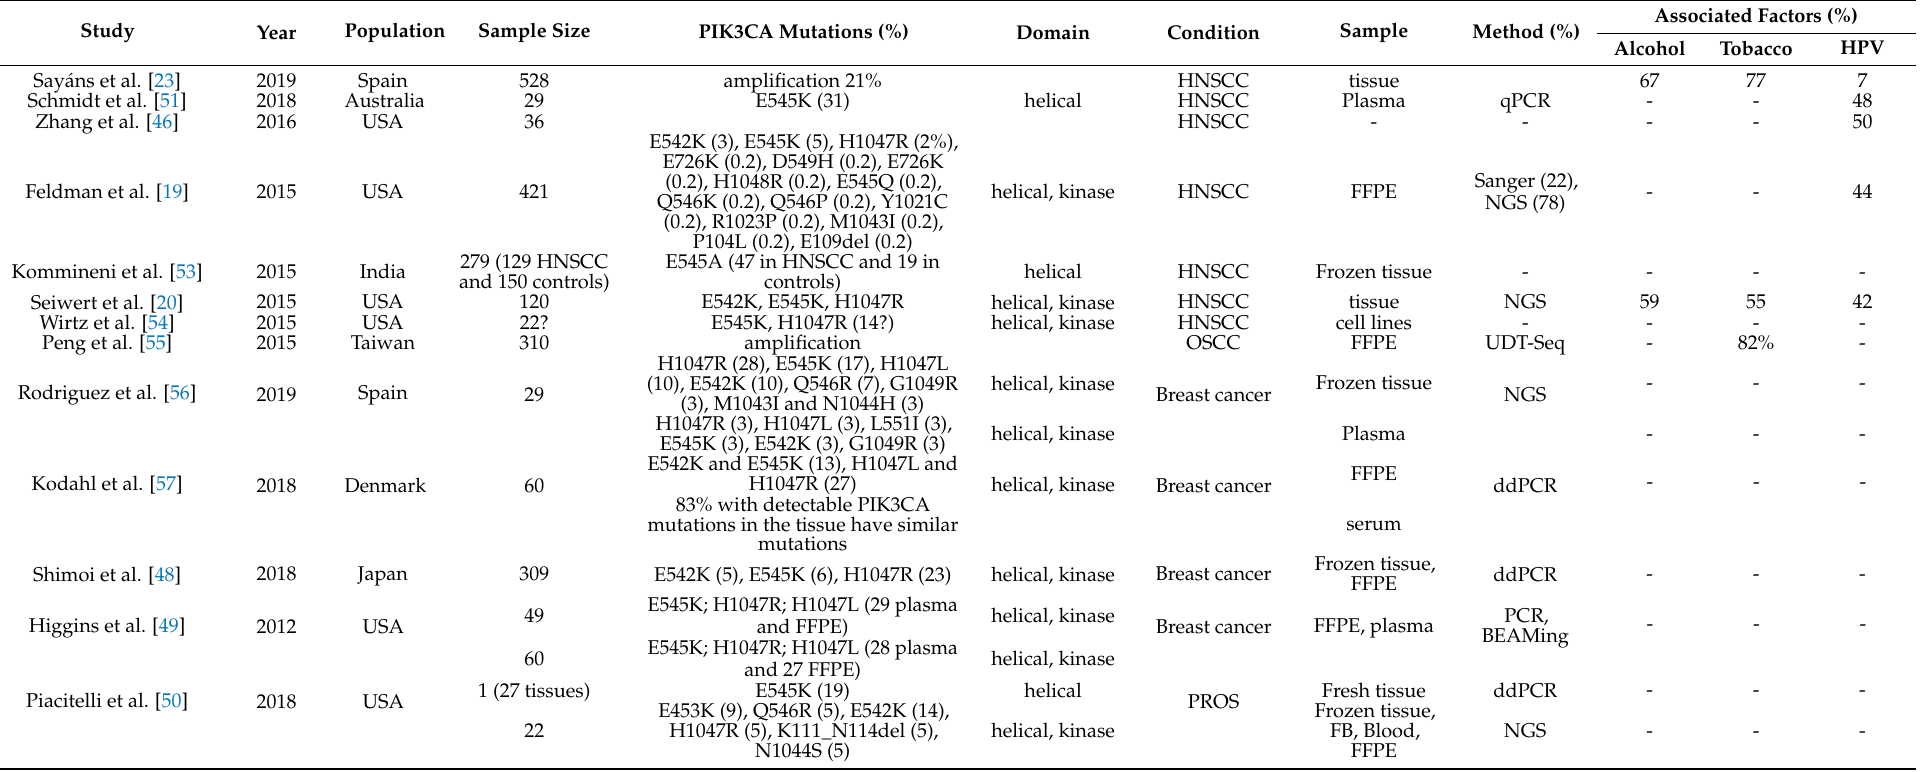
Table 4. PIK3CA mutations and amplifications in HNSCC, breast cancer and PROS (Abbreviations: HNSCC—head and neck squamous cell carcinoma, OSCC—oral squamous cell FFPE—formalin-fixed paraffin-embedded, FB—fibroblast, qPCR—real time quantitative polymerase chain reaction, UDT-Seq—ultra-deep targeted sequencing, NGS—next